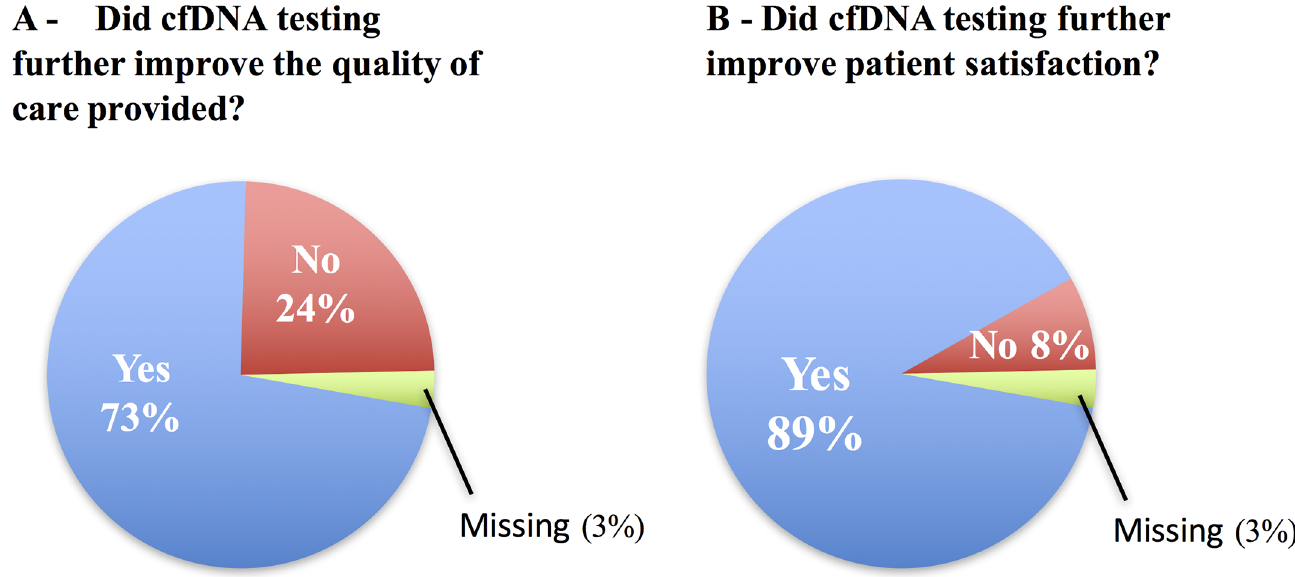
Fig 4. The impact of the use of cfDNA in (A) quality of care and (B) patient satisfaction.